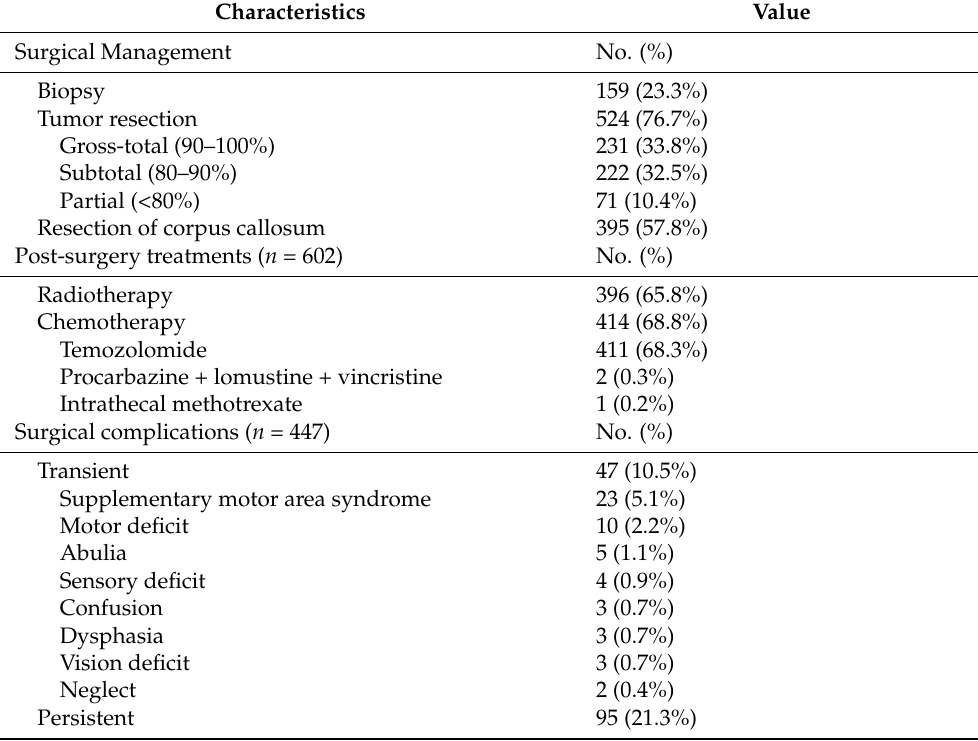
Table 2. Summary of treatment strategies and outcomes of all pooled